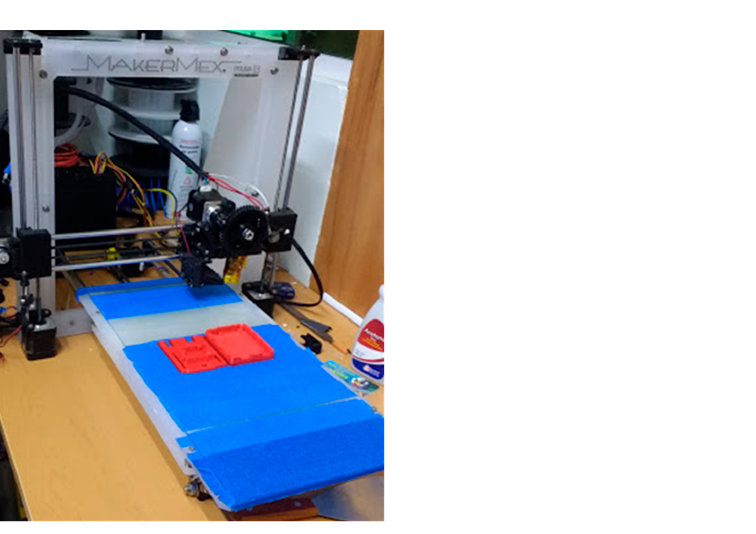
Figure 1. Sample experimentation plan.